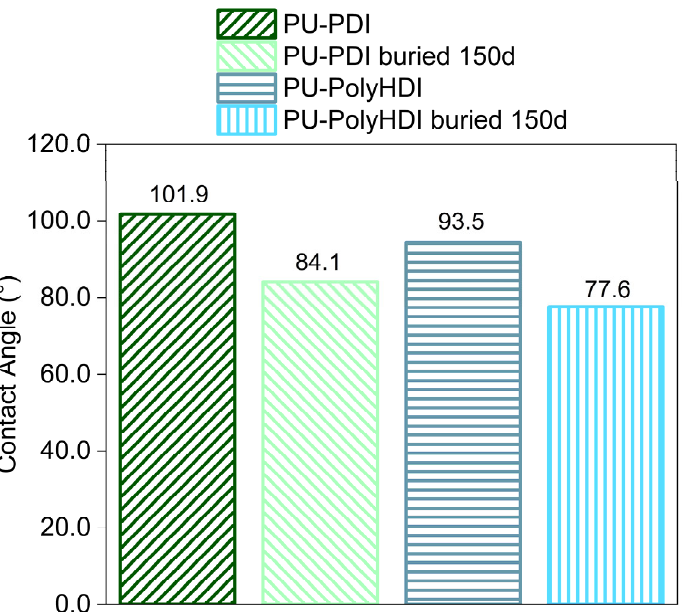
Figure 4. Average static contact angle values for the PU film samples virgin and buried (150 days).